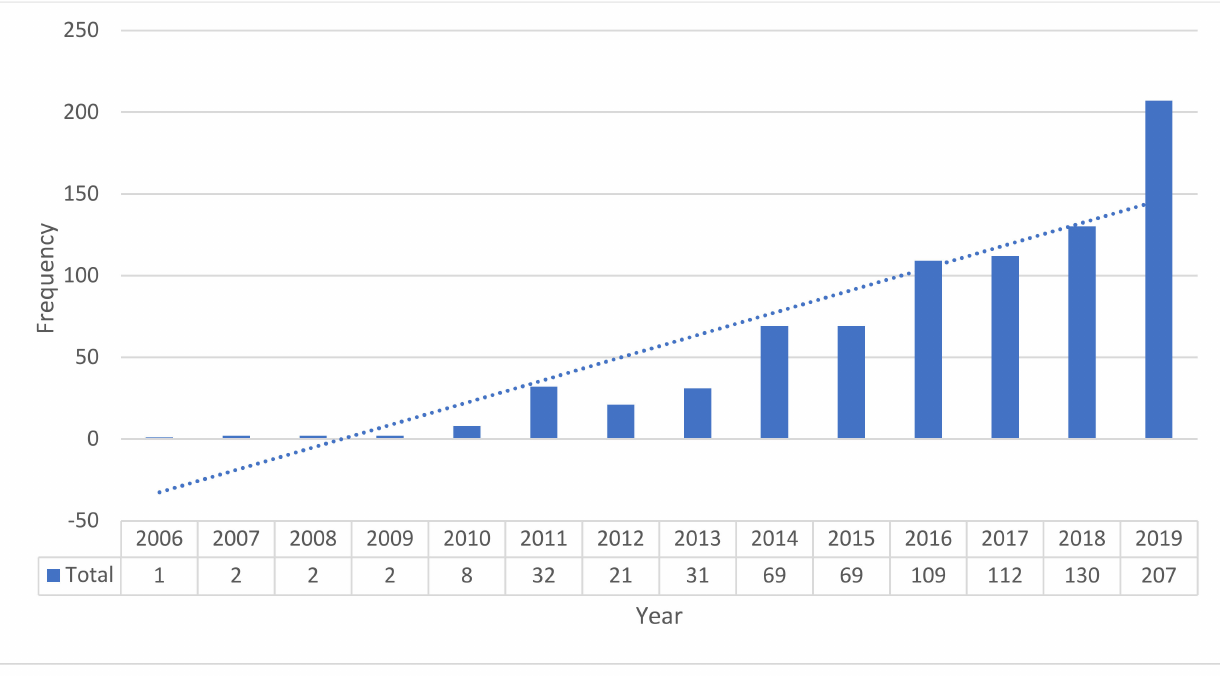
Figure 4. Annual BIM publication output in developing